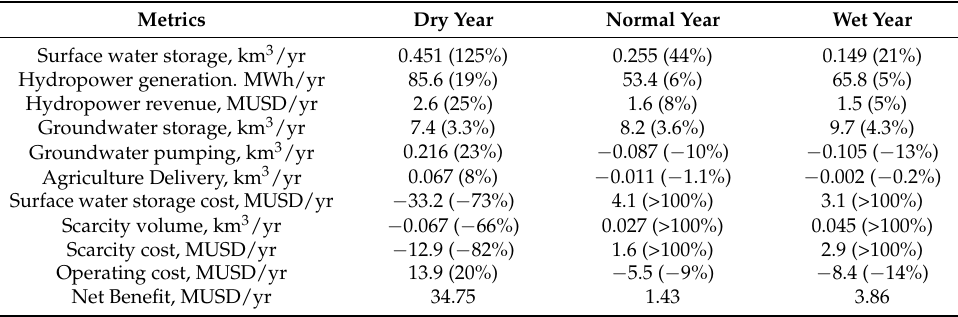
Table 10. Summary table of network system implying changes in shown metrics.